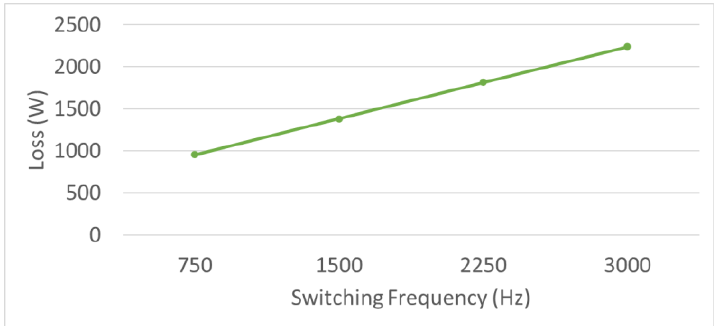
Figure 7. Loss analysis of SiC MOSFET depending on f sw : ( a ) 400 r/m; ( b ) 750 Hz.